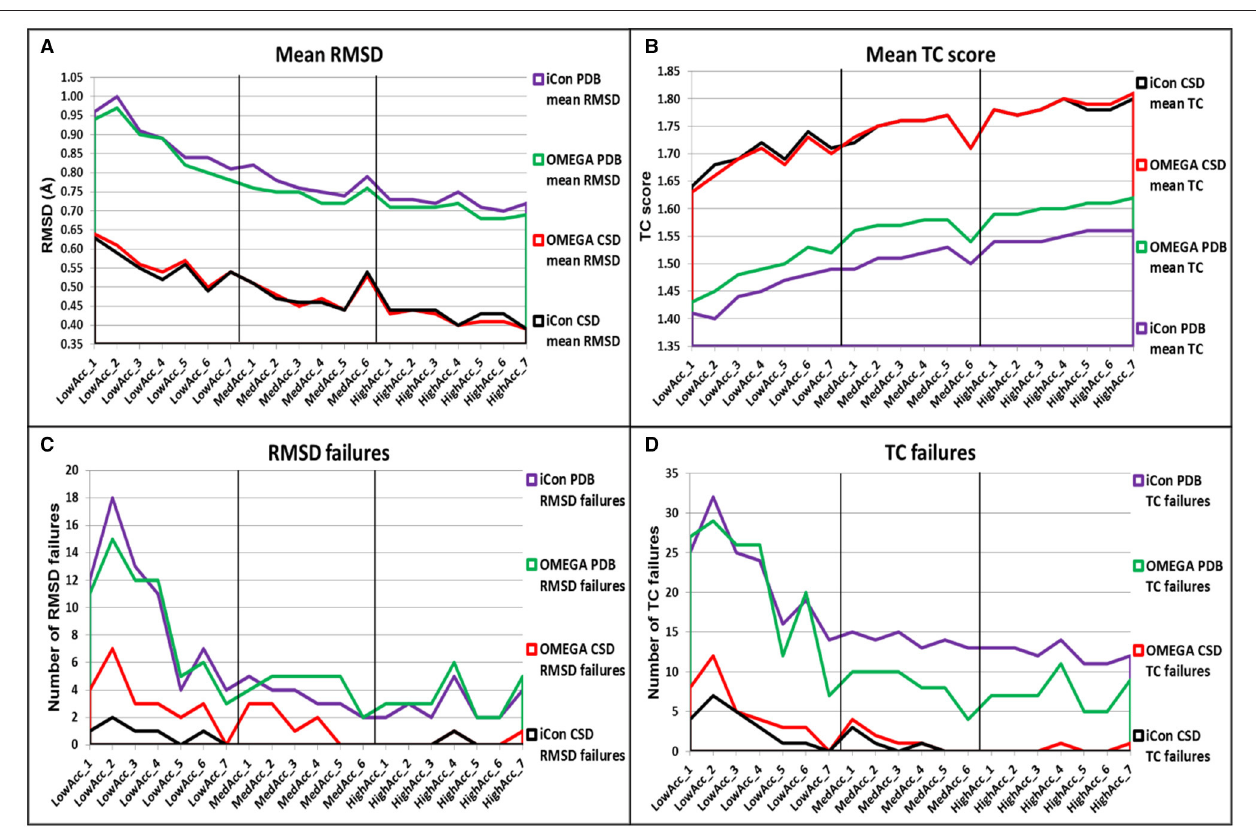
FIGURE 5 | Overall comparison of (A) mean RMSD values, (B) mean TC score values, (C) number of RMSD failure, and (D) number of TC failures obtained for PDB and CSD data set compounds by using iCon and OMEGA with the different setting patterns. Black vertical lines are used to separate the three different groups of